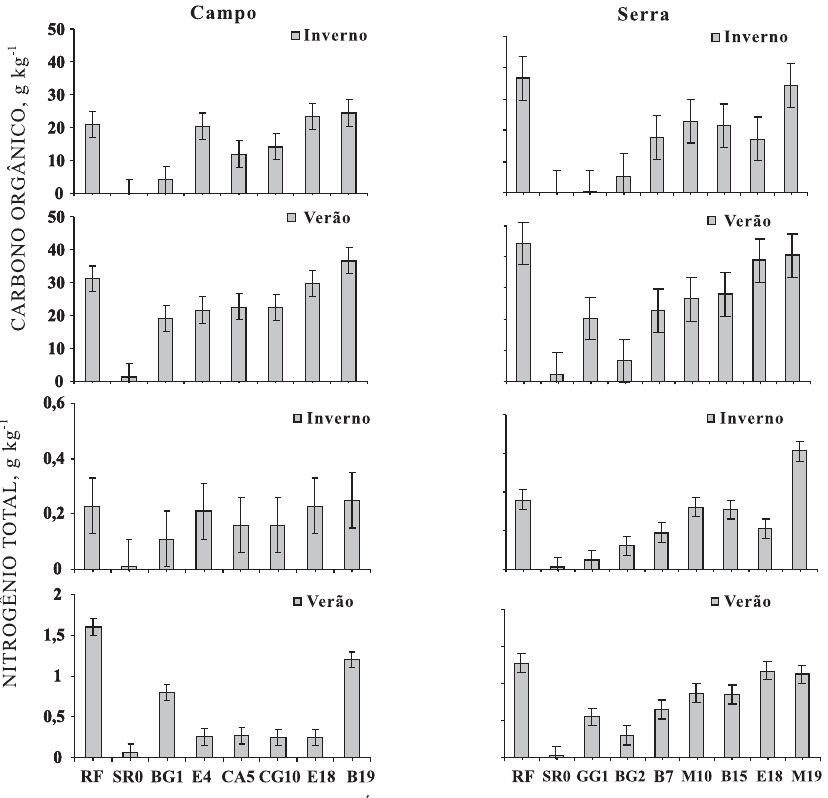
Figura 1. Carbono de compostos orgânicos e nitrogênio total do solo nas duas cronosseqüências de reabilitação (Campo e Serra) no verão e inverno comparado às áreas recém-mineradas e sem reabilitação (SR0) e a referência (RF). As linhas nas barras indicam os valores da DMS a 5 % pelo teste de